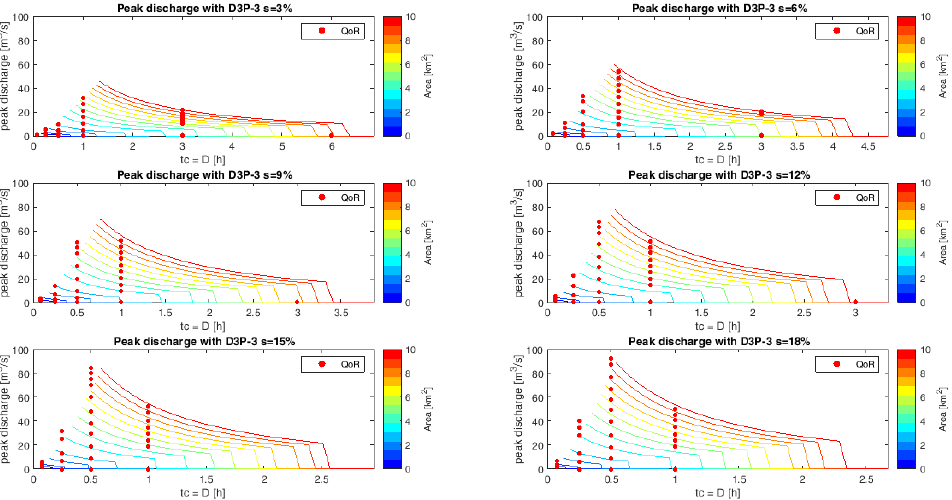
Figure 9. Peak curves obtained with D3P-2 vs. Q-Peak (red dots) evaluated with observed Rainfall.